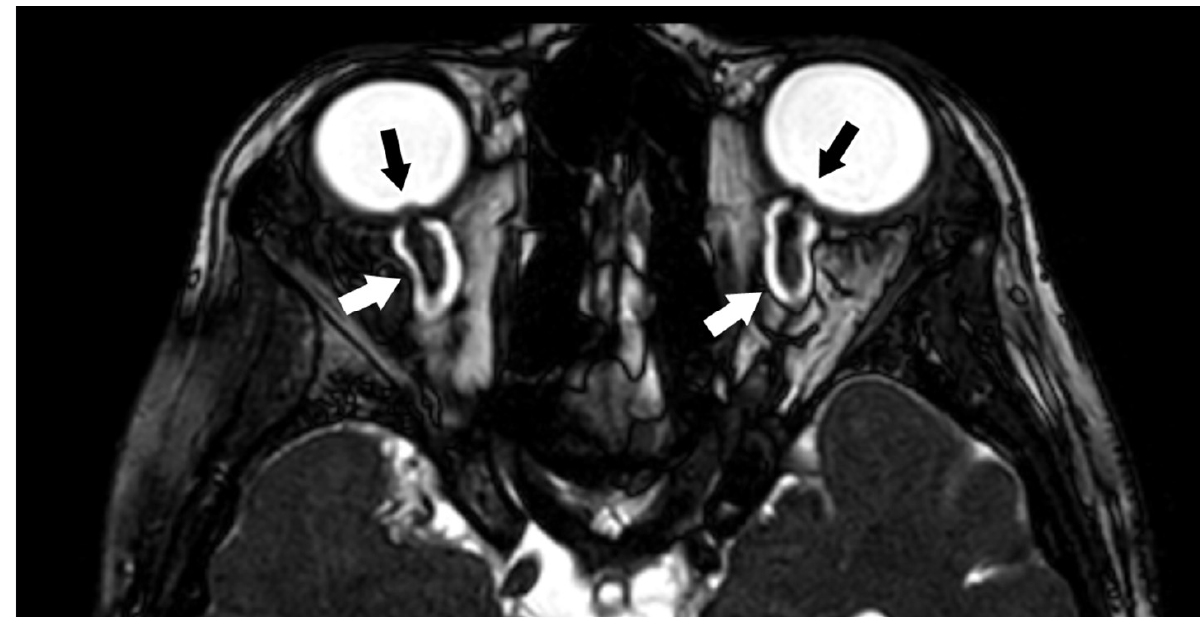
Figure 2. Axial three-dimensional constructive interference in steady-state (3D CISS) image showing in both sides posterior flattening of globes and protrusion of the optic nerve heads (black arrows), findings consistent with papilledema. Both optic nerves appear tortuous and the subarachnoid spaces surrounding them are enlarged (white arrows).